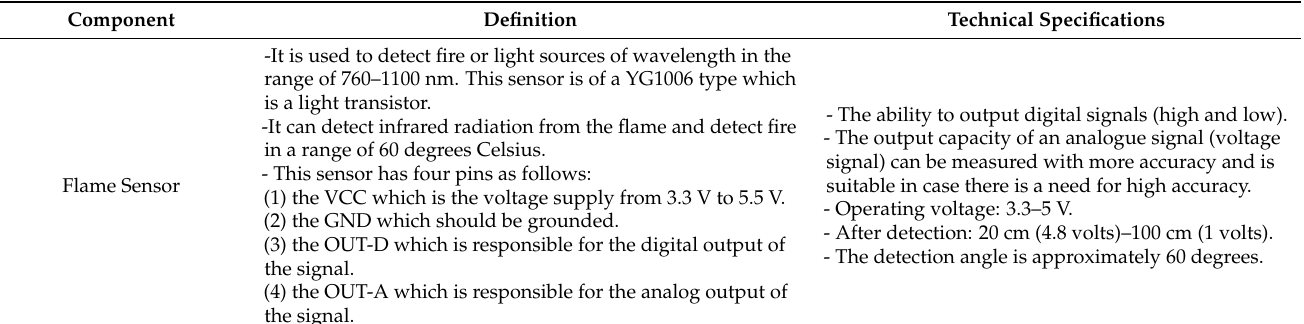
Table 5. The main components for the fire alarm system in the smart home.